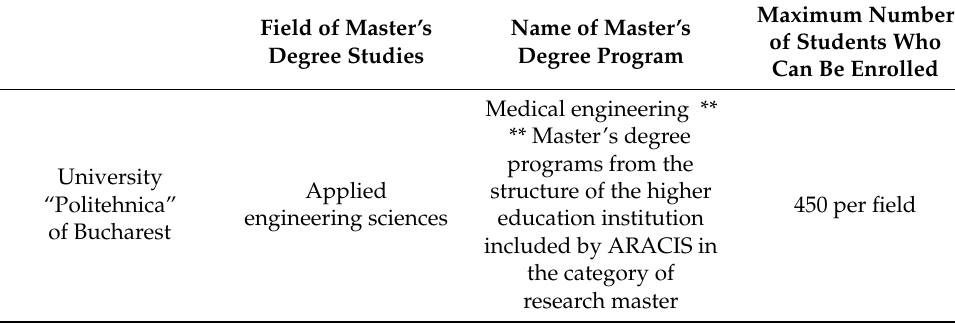
Table 4. B.Sc.-level BME specializations in Romania,